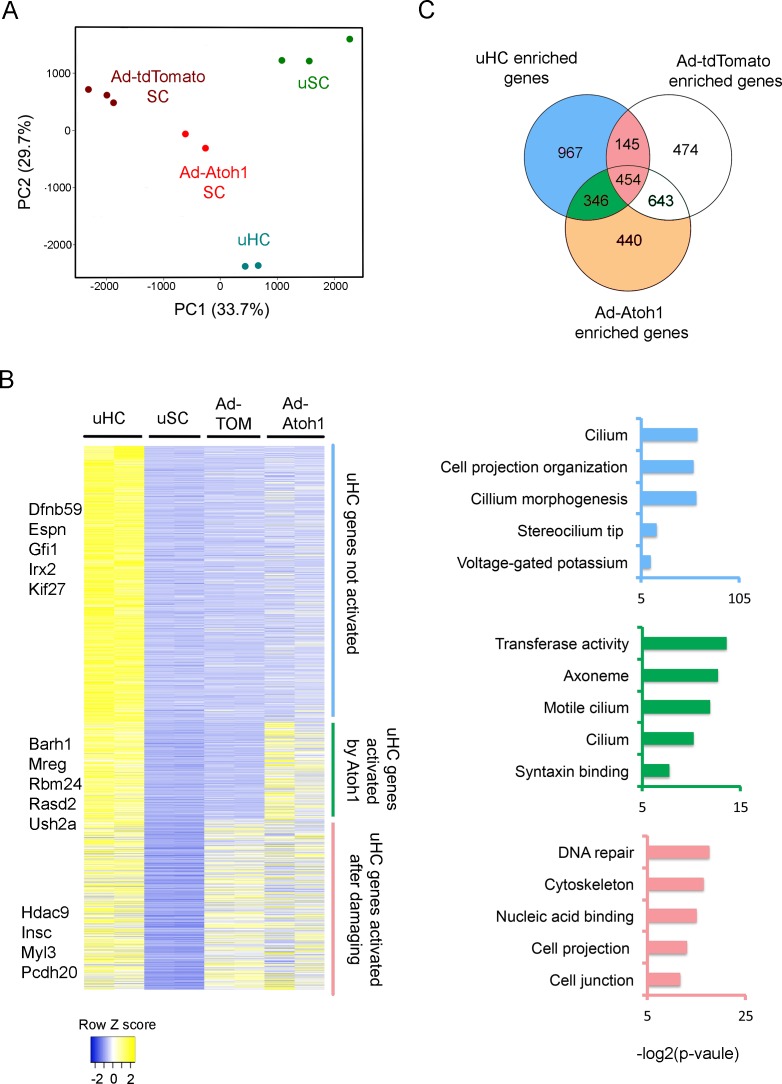
Activation of hair cell enriched genes and cell cycle genes in supporting cells after damaging to vestibular epithelium.(A) Principle component analysis (PCA) plot using the normalized counts for the RNA-seq data from endogenous utricle hair cells, utricle supporting cell, or utricle supporting cells infected with Ad-tdTomato or Ad-Atoh1. The PCA explain 33.7% (PC1) and 29.7% (PC2) of total variance. (B) Heatmap comparing gene expression level between different groups for all hair cell enriched genes. Genes were divided into three group based on their relative expression in viral infected groups compared with supporting cells. Gene sets were divided into three groups: Hair cell genes no activated in supporting cells; hair cells genes activated by damaging and transduction with Atoh1; hair cell genes activated by damage alone. Examples of known genes are indicated for each group. (C) Venn diagram comparing genes enriched in hair cells and genes enriched in either Ad-tdTomato or Ad-Atoh1 infected supporting cells. Gene ontology analysis of enriched pathways or keywords using genes enriched only in Ad-Atoh1 infected cells (green), enriched in Ad-tdTomato infected cells (pink) and only enriched in utricle hair cells (purple).